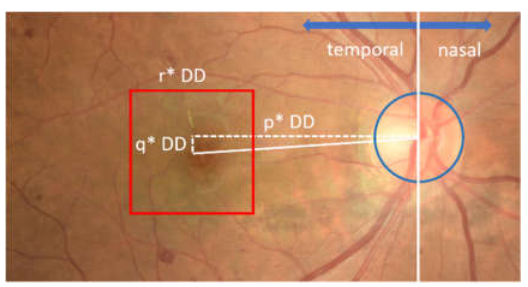
Figure 6. Illustration of macular ROI determination. The red box shows the macular ROI.